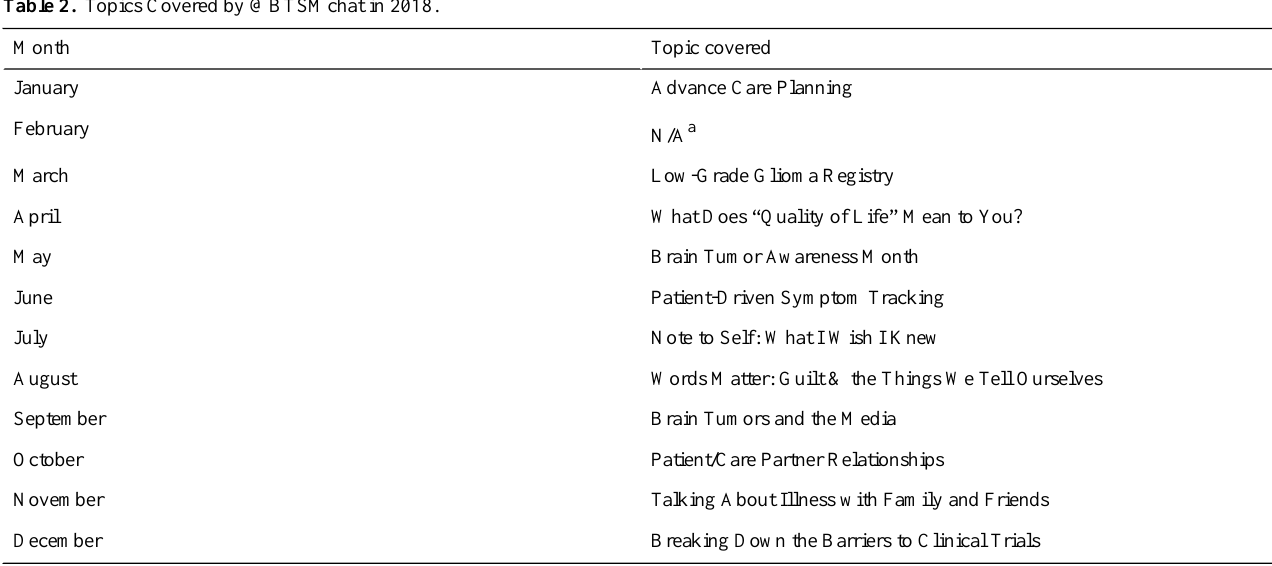
Table 2. Topics Covered by @BTSMchat in